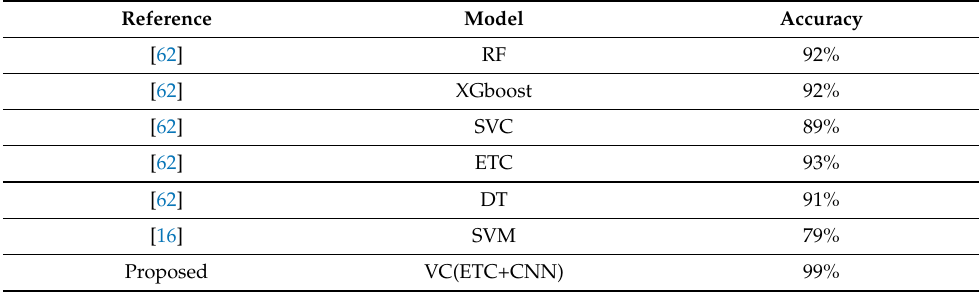
Table 7. Comparison of proposed approach with state-of-the-art